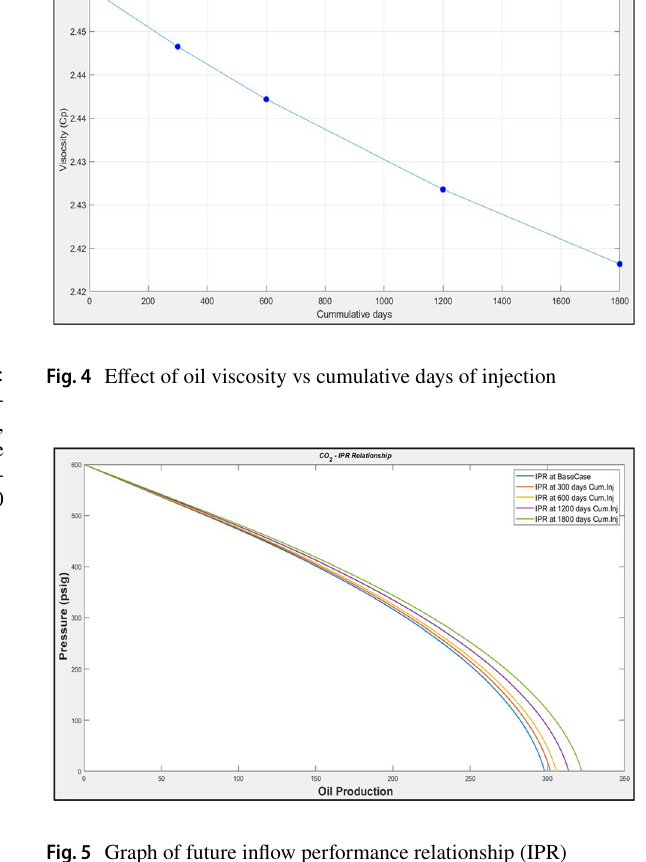
Fig. 5 Graph of future inflow performance relationship (IPR)